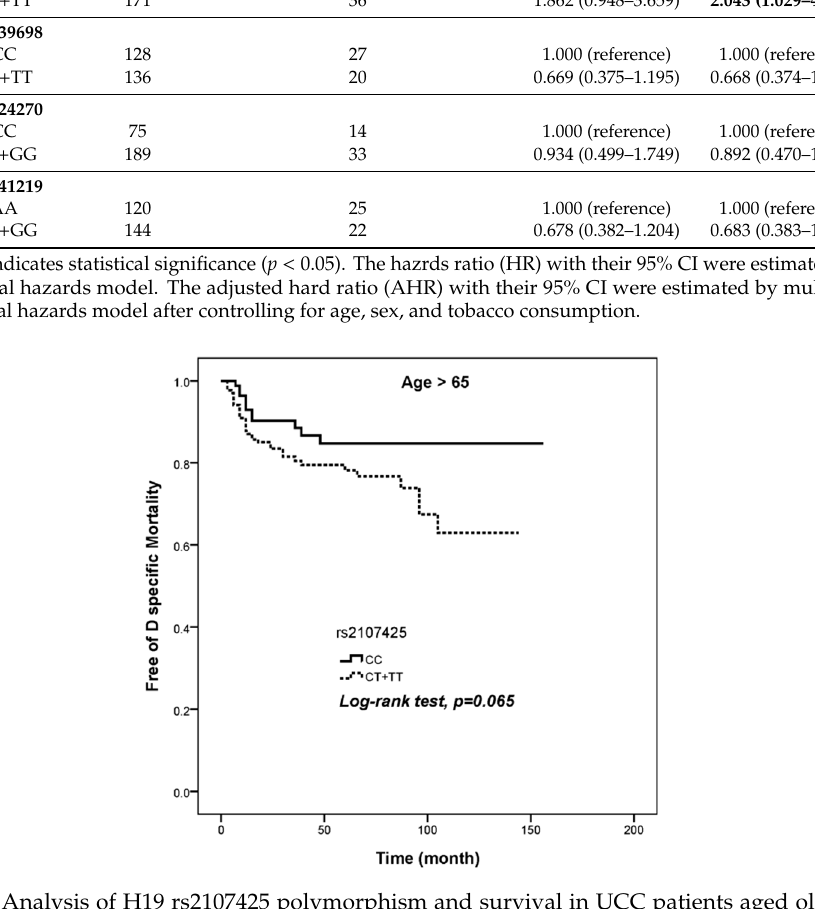
Table 5. Risk of disease-specific mortality on genotype distributions of H19 gene polymorphisms among 264 UCC patients over 65 years old.